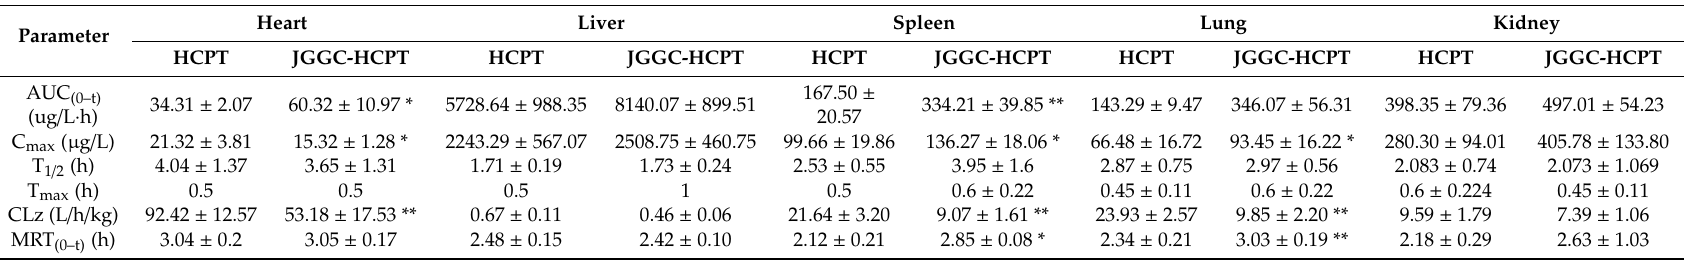
Table 4. Mean pharmacokinetic parameters of HCPT in HCPT alone and HCPT combination with Platycodonis Radix-Glycyrrhizae Radix ET Rhizoma (JGGC).